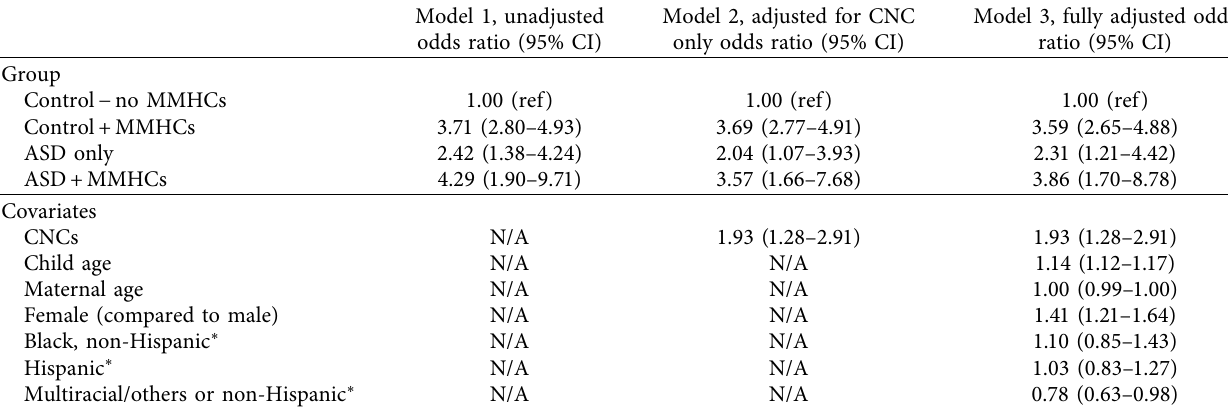
Table 2: Weighted odds ratios of pain in children with and without ASD and of mothers with and without “Fair or Poor” mental health. Model 1,